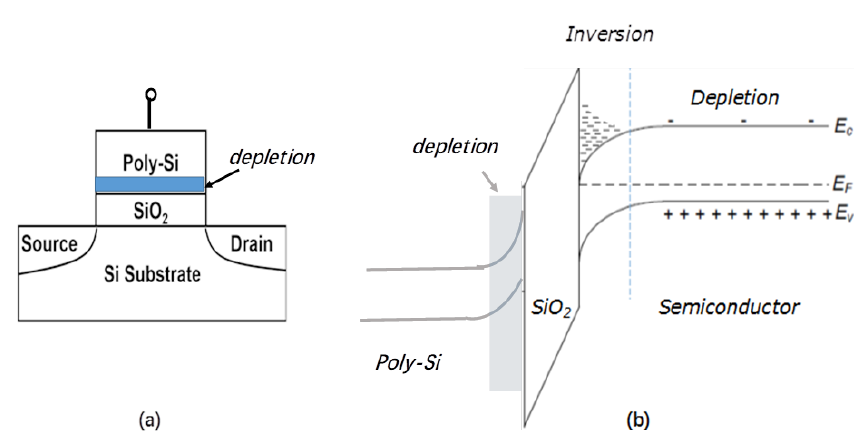
Figure 6. Depletion layer formed in poly-Si. ( a ) schematic of a MOSFET; ( b ) band structure of poly-Si/oxide/semiconductor.